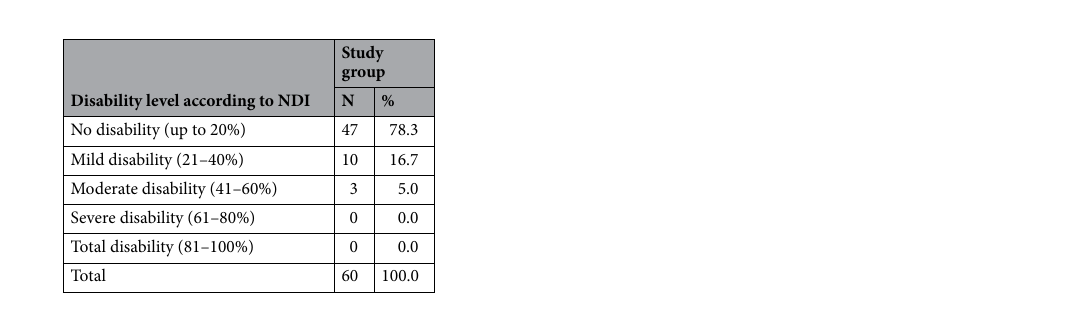
Table 4. The subjects’ disability level according to NDI.